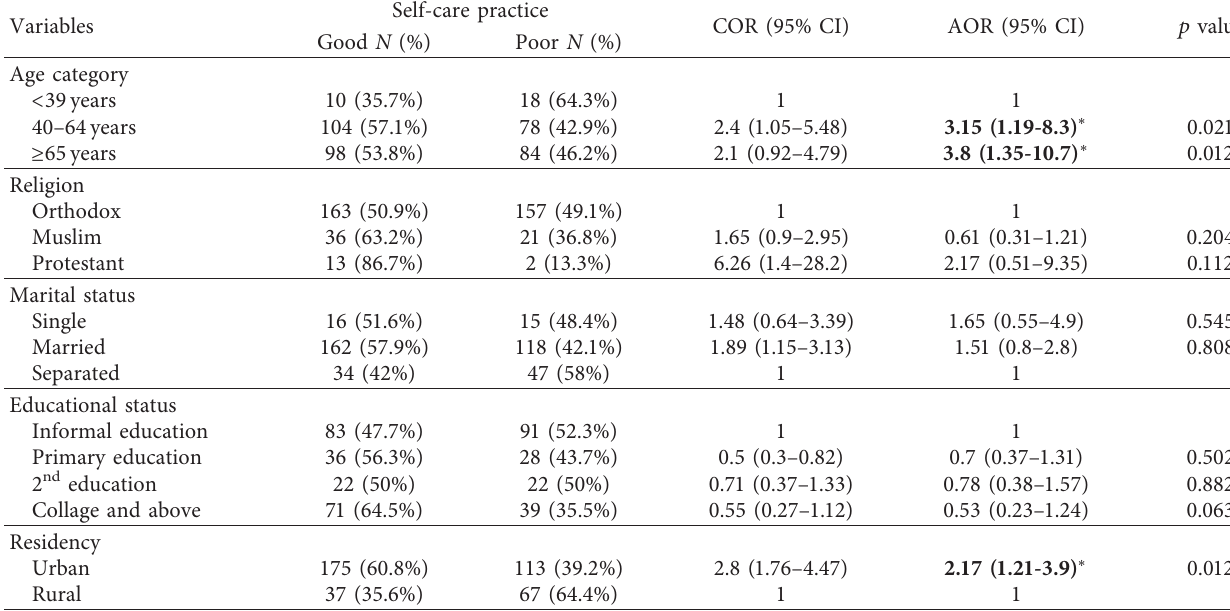
Table 6: Factors associated with self-care practice of hypertensive patients in Debre Tabor Referral Hospital, Northwest Ethiopia, 2020 ( n �